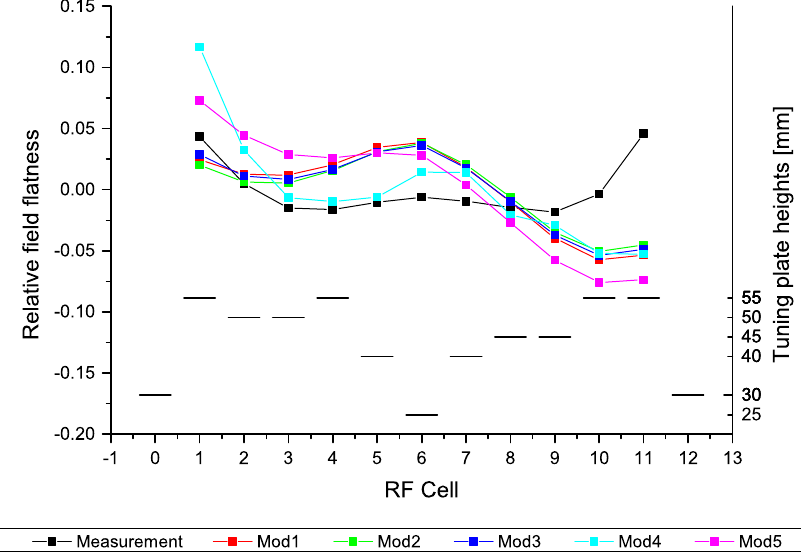
FIG. 2 (color online). Comparison of a measured field flatness with its MWS simulation. In this figure, a measured field flatness of the FNAL RFQ (black squares) for a given tuning plate distribution ( — ) is compared to the simulation of the fully imported model of this RFQ that has the same tuning setup (Mod1 to Mod5). The simulation models differ in their meshing which has been refined in several steps. All of the simulated field flatness results show a slope from the low energy to the high energy end that is not present in the measurement. The simulated values can deviate up to 14% from the measured value.